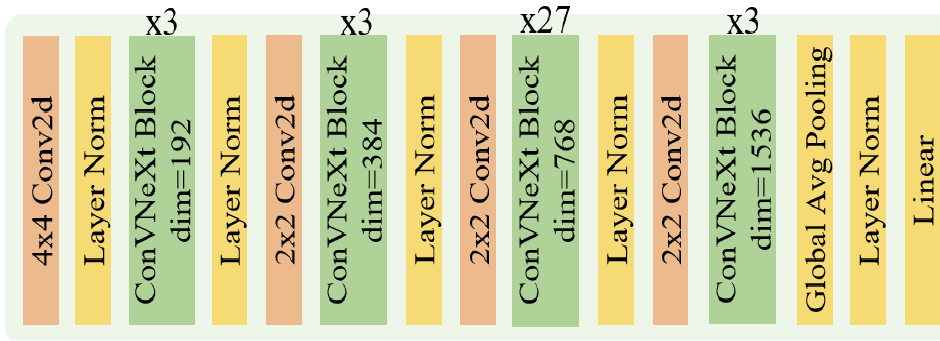
Figure 8. Support set feature extraction backbone.